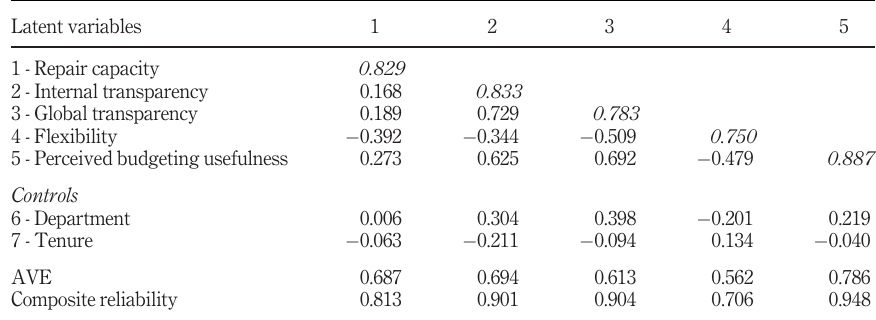
Table 2. Latent variable